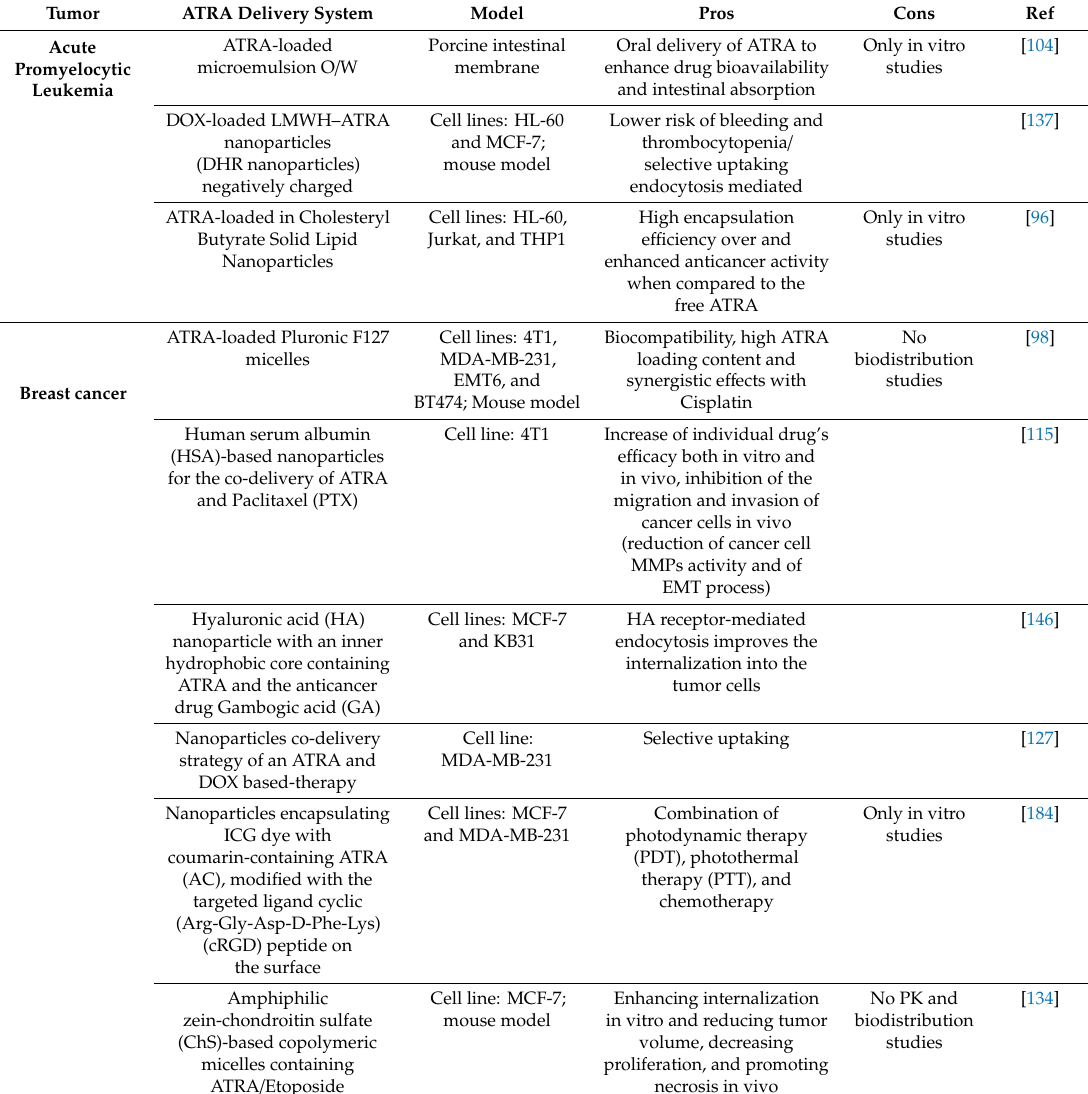
Table 1. ATRA delivery systems in cancer. Critical summary of analyzed studies on di ff erent DDSs grouped by tumor